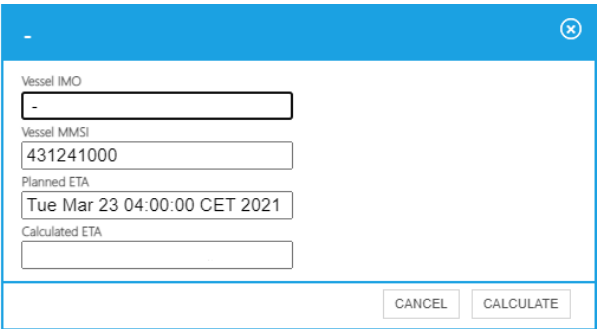
Figure 5. Basic vessel information.